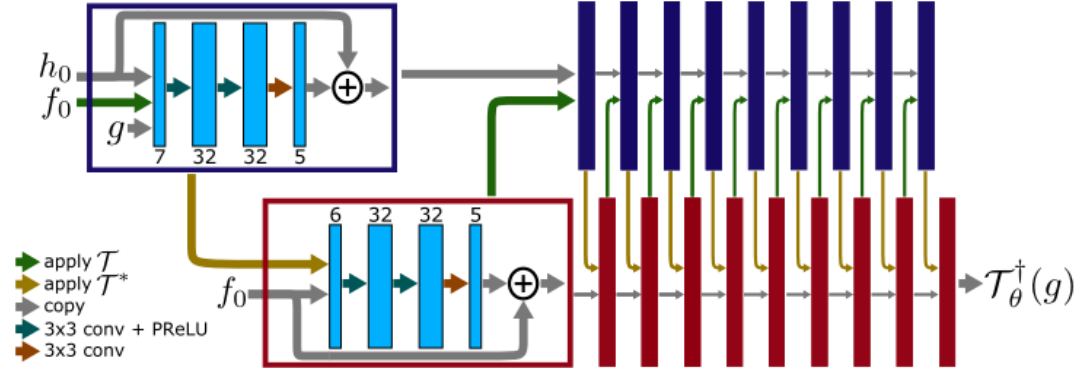
Figure 5. Illustration of the PD-net from [9]. Here, T denotes the measurement operator, which in our case is the under-sampled Fourier transform, T ∗ its adjoint, g is the measurements, which in our case are the undersampled k-space measurements, and f 0 and h 0 are the initial guesses for the direct and measurement spaces (the image and k-space in our case). The initial guesses are zero tensors. Because we transform complex-valued data into 2-channel real-valued data, the number of channels at the input and the output of the convolutional subnetworks are multiplied by 2 in our